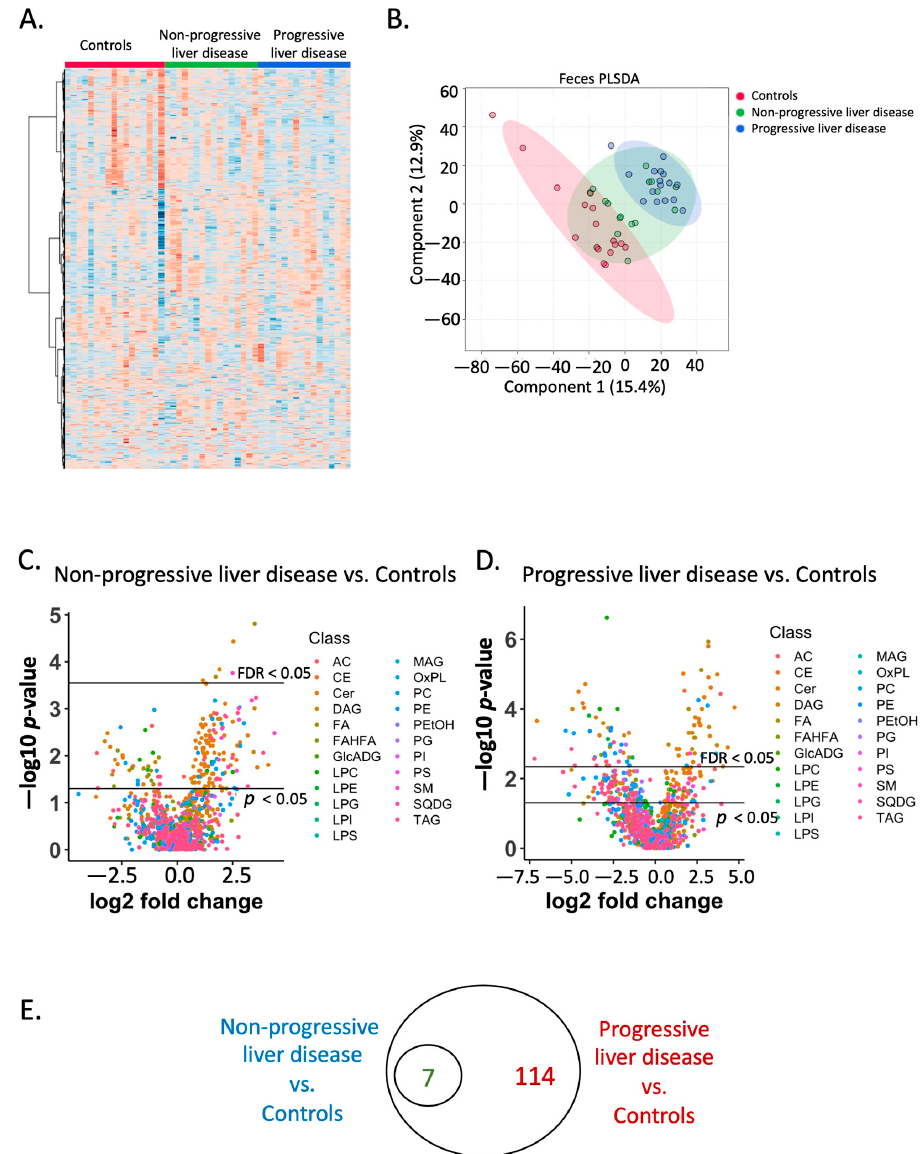
Figure 2. Fecal lipidome. ( A ) Heatmap of the fecal lipidome in the control and two patient groups. ( B ) Partial least squares-discriminant analysis of the fecal lipidome. ( C ) Volcano plot of the fecal lipidome in control subjects and patients with non-progressive liver disease. Different colors represent different lipid classes. Fold change: non-progressive liver disease ( n = 16)/controls ( n = 17). ( D ) Volcano plot of the fecal lipidome in control subjects and patients with progressive liver disease. Different colors represent different lipid class. Fold change: progressive liver disease ( n = 16)/controls ( n = 17). ( E ) Venn diagram of significant fecal lipids (adjusted p -value < 0.05). Red: number of unique, significant lipids between progressive liver disease and controls; Dark green: shared significant lipids.